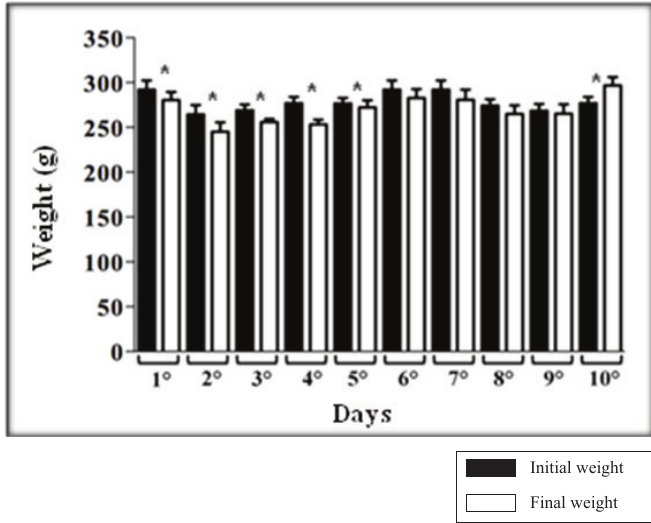
FIGURE 4 - Daily variation of the body weight of the animals subjected to the process of traumatic ulcer induction in the cheek mucosa over the 10-day period. The data are presented as mean ± SEM The statistical analysis was performed using Student’s t-test with p<0.01. * Data with statistical significance on the 1st, 2nd, 3rd, 4th, 5th and 10th